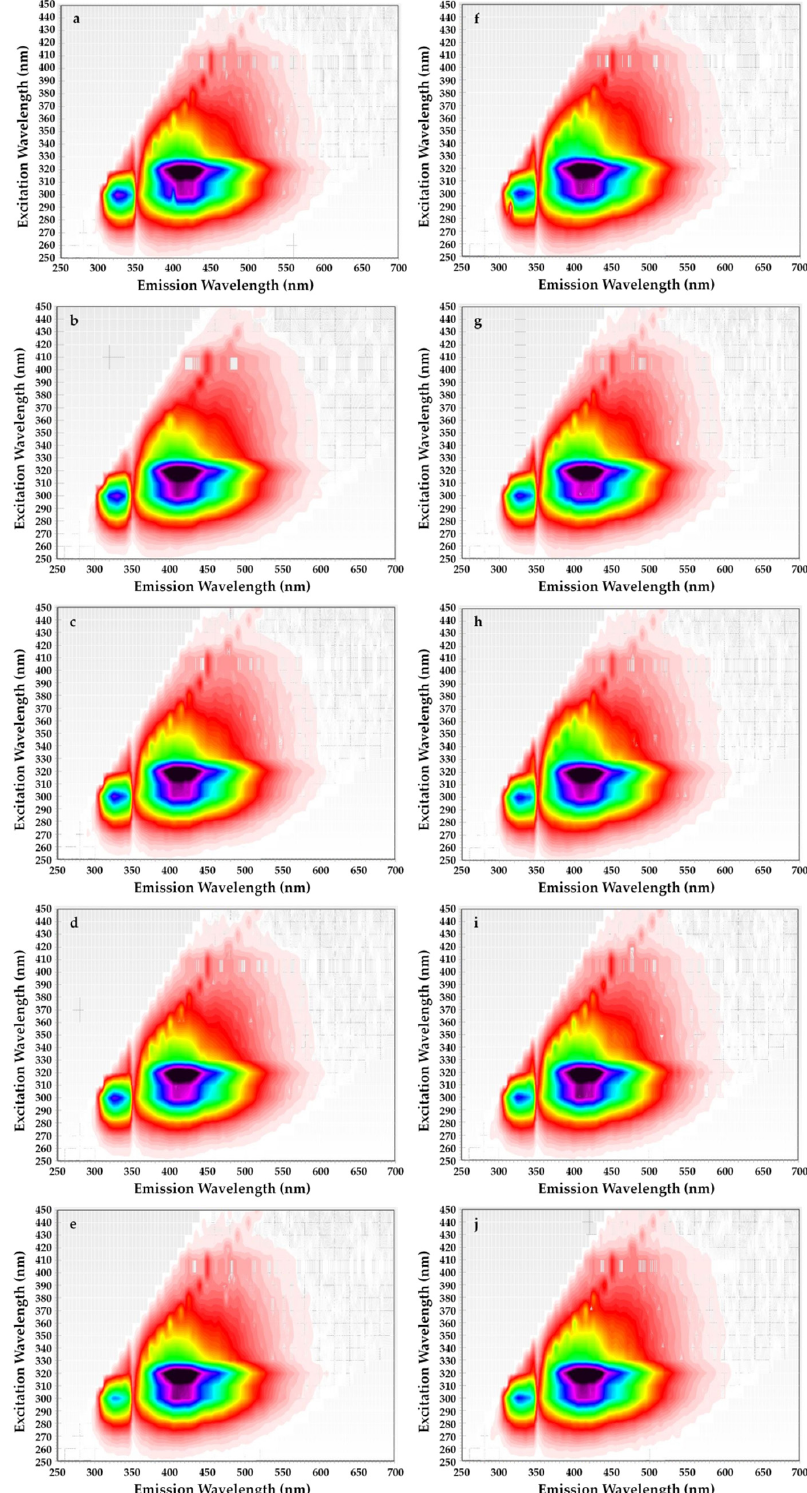
Figure 5. Excitation–emission matrices of refined rapeseed oils without β -sitosteryl sinapate ( a – e ) and refined rapeseed oils with β -sitosteryl sinapate ( f – j ) after 0, 1, 2, 3 and 4 weeks of storage at accelerated